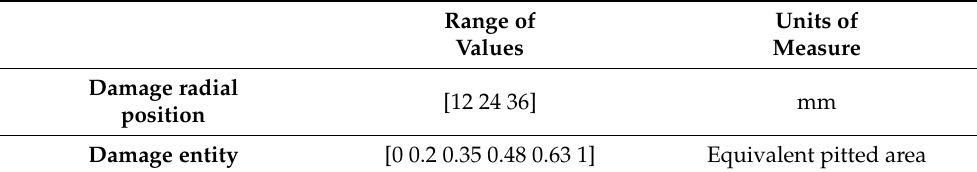
Table 3. Training dataset composition.